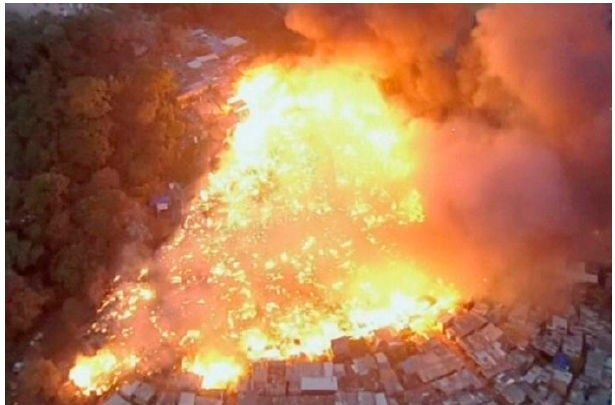
Figure 1. Fire in the Estrada de Alpina favela of São Paulo [3].